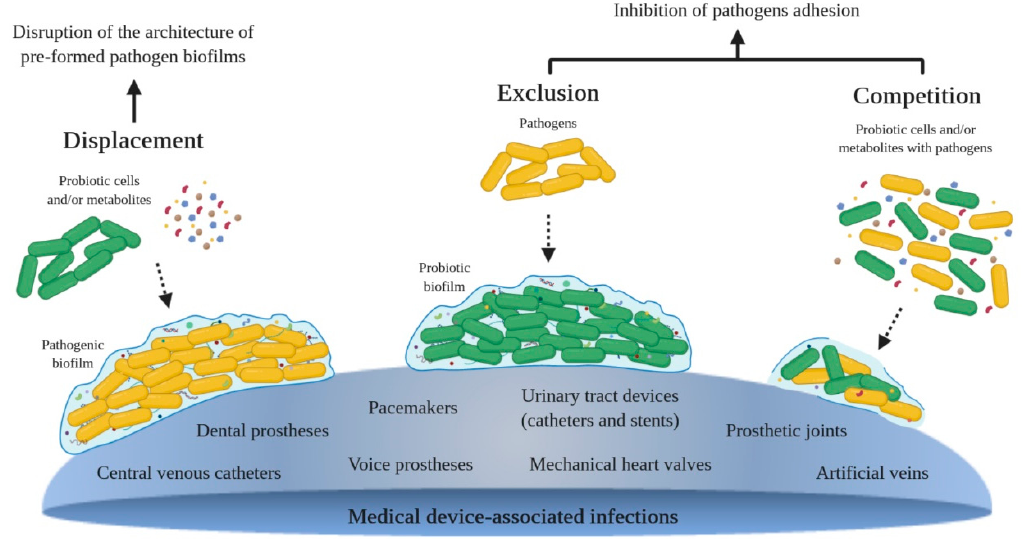
Figure 1. Antibiofilm strategies of probiotic cells and/or their metabolites: displacement–probiotics and/or their substances are added to a pre-formed pathogen biofilm; exclusion–pathogenic cells are added to a pre-formed probiotic biofilm or to a surface pre-coated with antibiofilm substances isolated from probiotics; competition–probiotic cells and/or their substances and pathogenic cells are